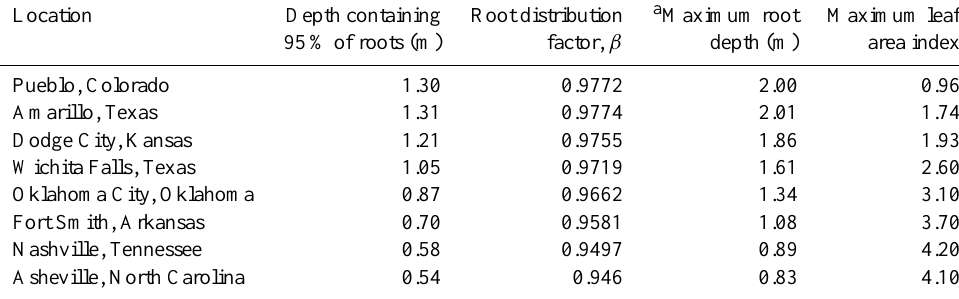
Table 3. Estimated root depth and distribution and maximum leaf area at the eight